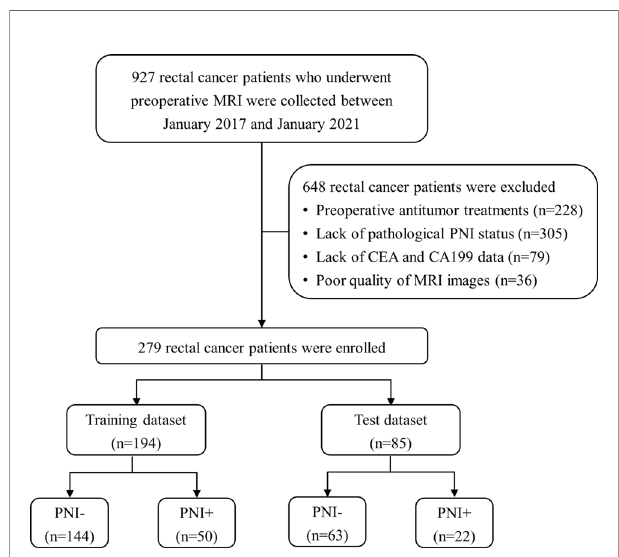
FIGURE 1 | Patient recruitment process. (PNI-, patients without pathologic perineural invasion; PNI+, patients with pathologic perineural invasion; CEA, carcinoembryonic antigen; CA19-9, carbohydrate antigen